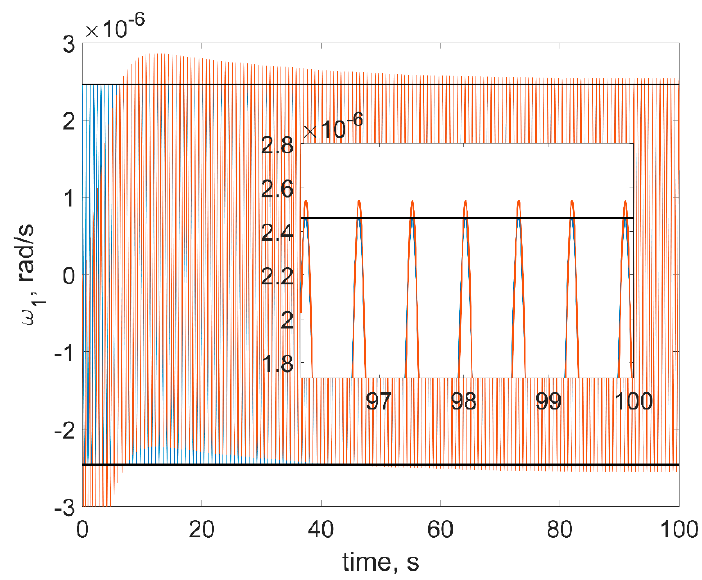
ω for static imbalance case (red is numerical solution, blue is approximate Figure 11. Evolution of Figure 11. Evolution of ω 1 for static imbalance case (red is numerical solution, blue is approximate 1 solution, horizontal lines are the estimations). solution, horizontal lines are the estimations).